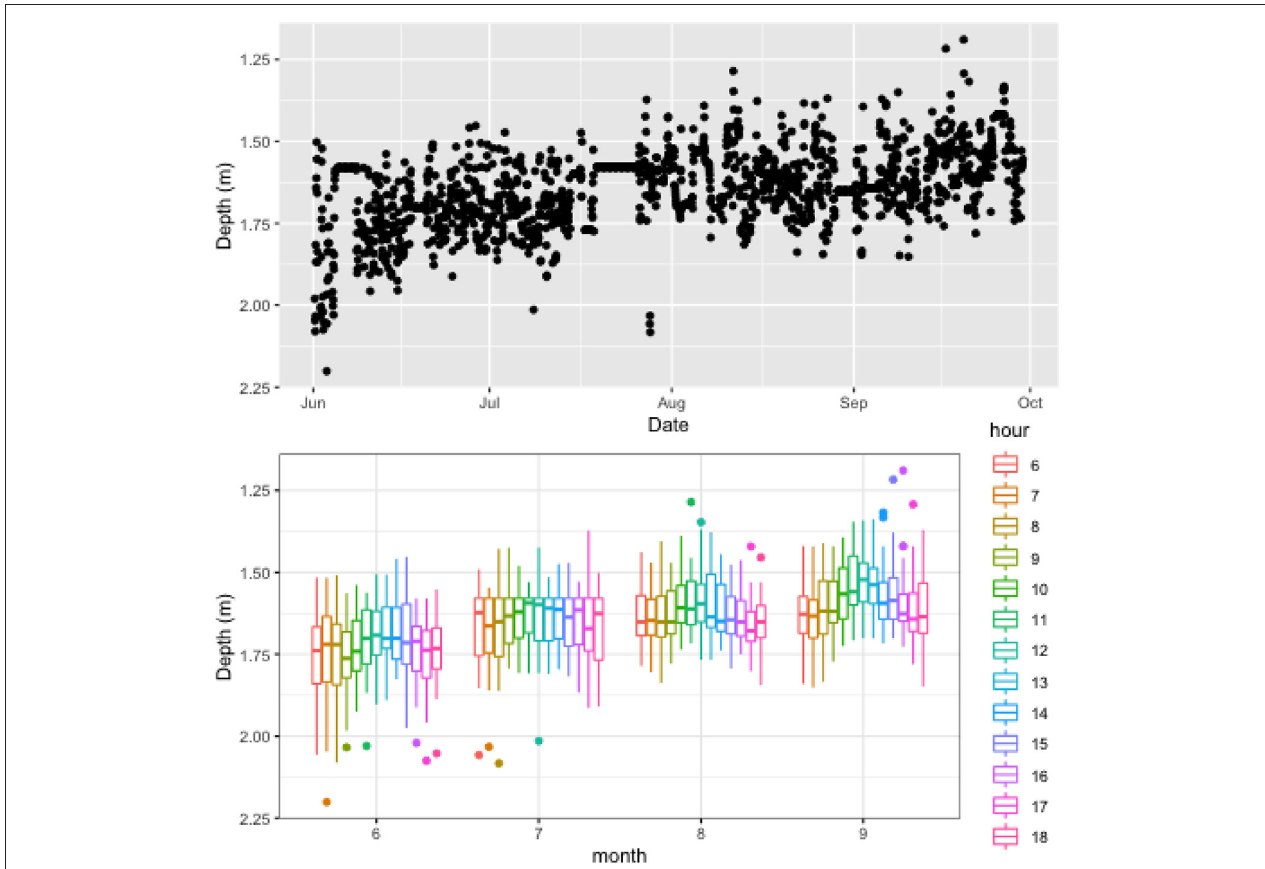
FIGURE 4 | Vertical distribution of fish in a cage at SCO farm illustrating the evolution of the centrepoint of fish biomass over the duration of study period (top) and boxplot of the data grouped into hourly intervals for each month (bottom). The box plot provides insight into distinct patterns developing in the data at different times with the color legend representing hour of day.Lines extending from the boxplot represent the range of data (i.e., minimum and maximum values), while the box section reports 25th percentile, median, and 75th percentile values. Filled circles represent outliers for the data. Note that the plots only include data between 06:00 and